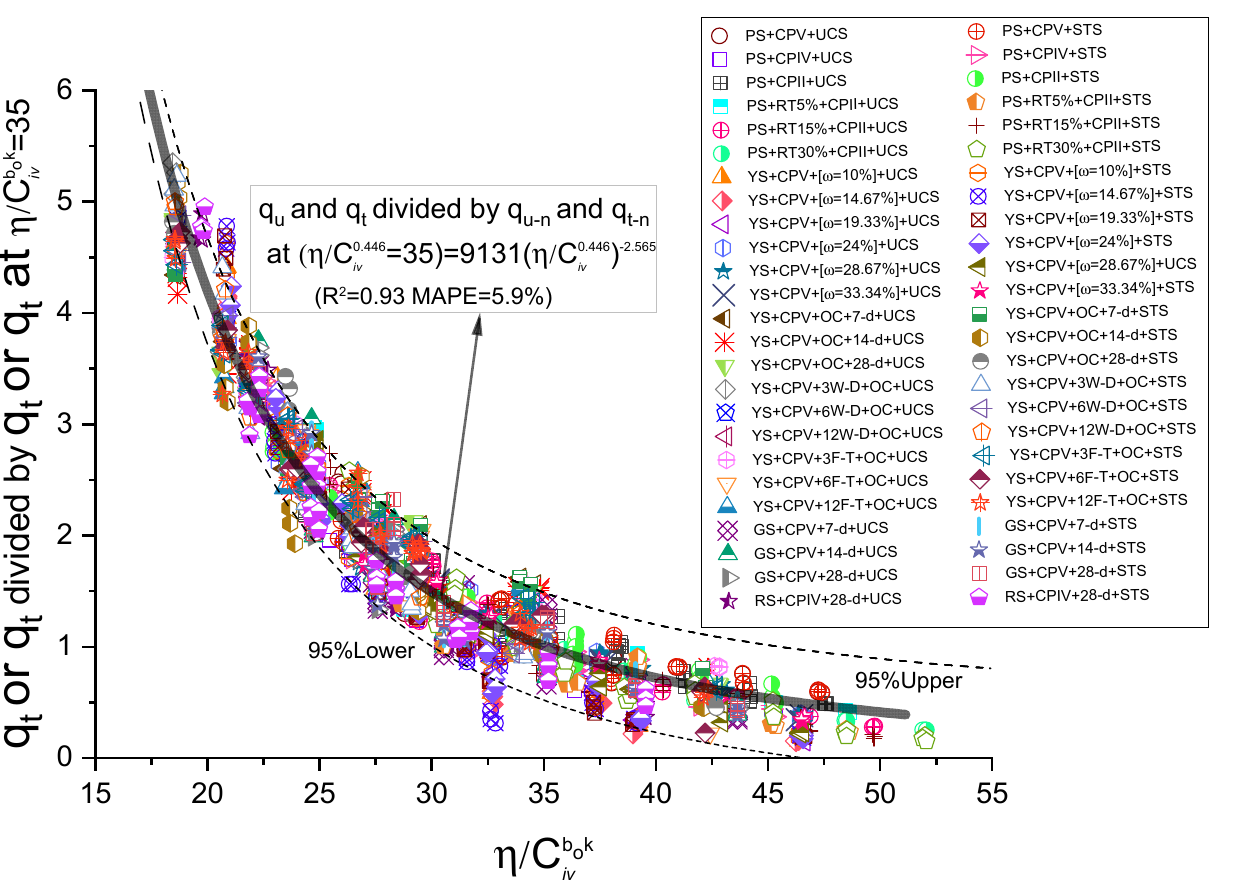
Figure 7. Normalization of unconfined compressive strength (q u ) and split tensile strength (q t ) (for the whole range of η /C iv 0.446 ) by dividing for q u and q t at η /C iv 0.446 = 35 (see Table 7) considering strength of cement-treated silty soils using 7, 14 and, 28 days of curing and several types of moisture- molding content.